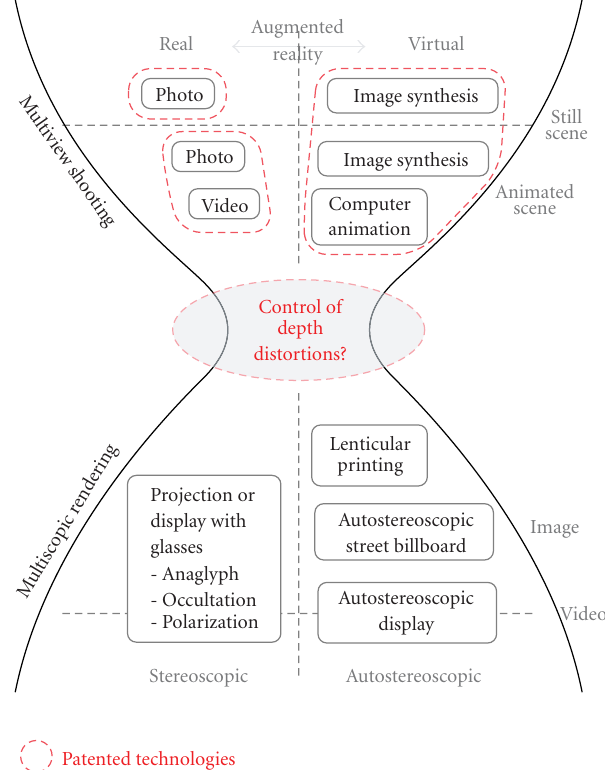
Figure 1: Shooting to rendering